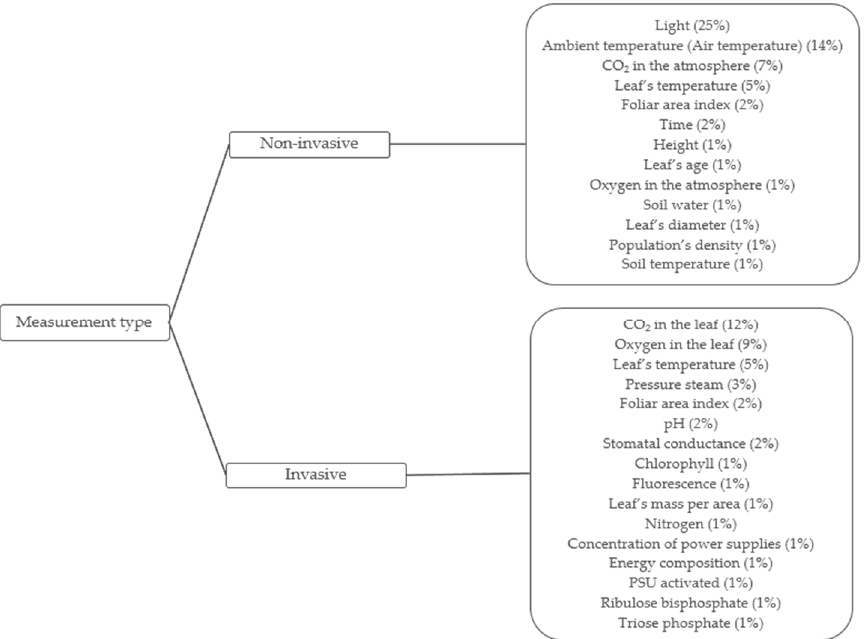
Figure 5. Input variables used by the mathematical models to estimate photosynthesis; invasiveness based on their measurement; as well as the equivalent percentage to the number of times that the models use these variables.